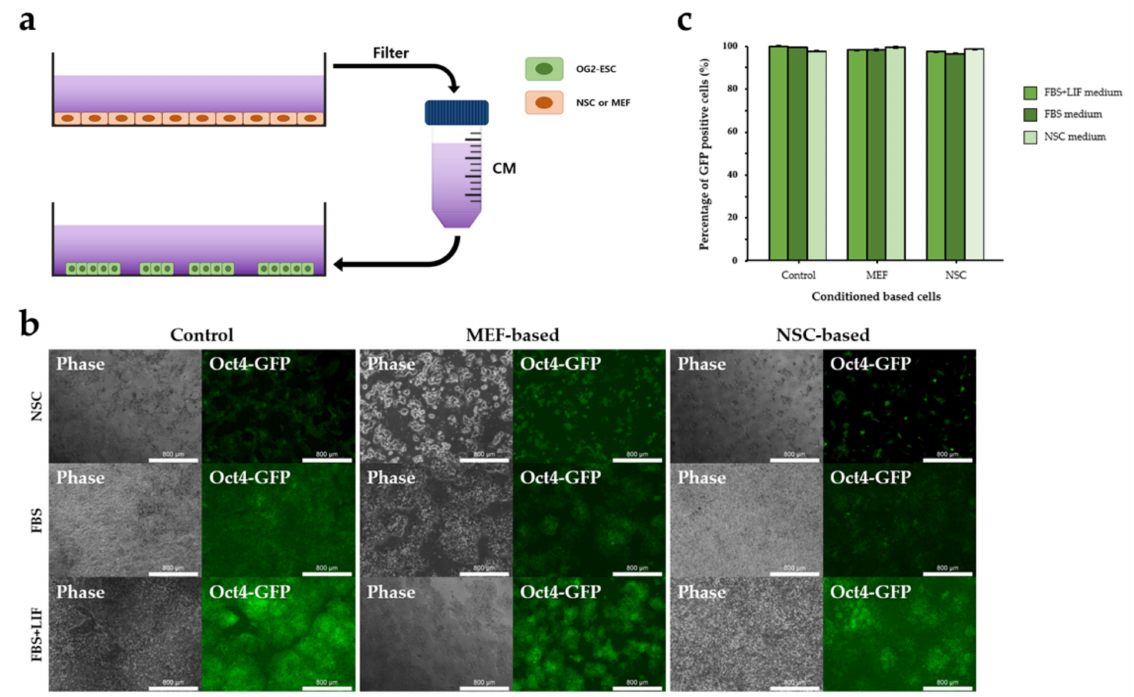
Figure 2. OG2-ESC cultured with CM under 2D condition. ( a ) CM prepared from the NSCs after 72 h in culture and used in the 2D culture of undifferentiated ESCs. ( b ) Phase and fluorescence (GFP) images of 2D OG2-ESCs cultured in non-conditioned medium or NSC- or MEF-based conditioned FBS, FBS+LIF, and NSC medium for 6 days. Scale bar = 800 µ m. ( c ) Flow cytometry analysis of the percentage of Oct4-GFP-positive cells cultured in non-conditioned or CM under 2D condition for 6 days. Data are mean ± SE, n = 3 biological